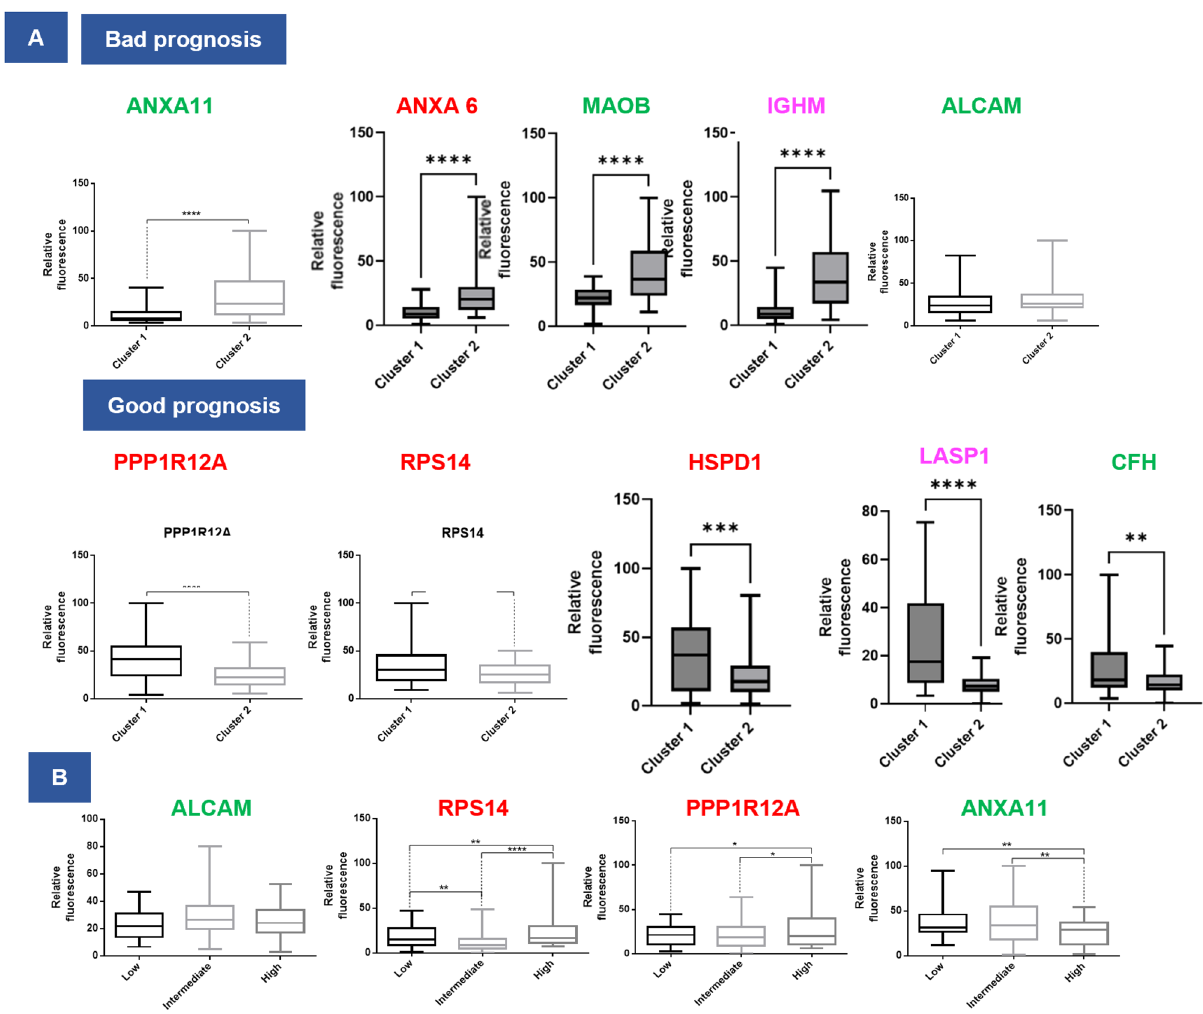
Fig.5|Quanti fi cationofthepanelofsurvivalmarkersidenti fi ed. Quanti fi cation of fl uorescence intensities of ( A ) the ten proteins in the two OS clusters. Images takenfrom 14tumorsofcluster1 and 9tumorsofcluster2and ( B )4proteins inan external cohort of glioblastoma patients (50 patients). Patients were classi fi ed according to their survival times (low, intermediate, and high). The fl uorescence